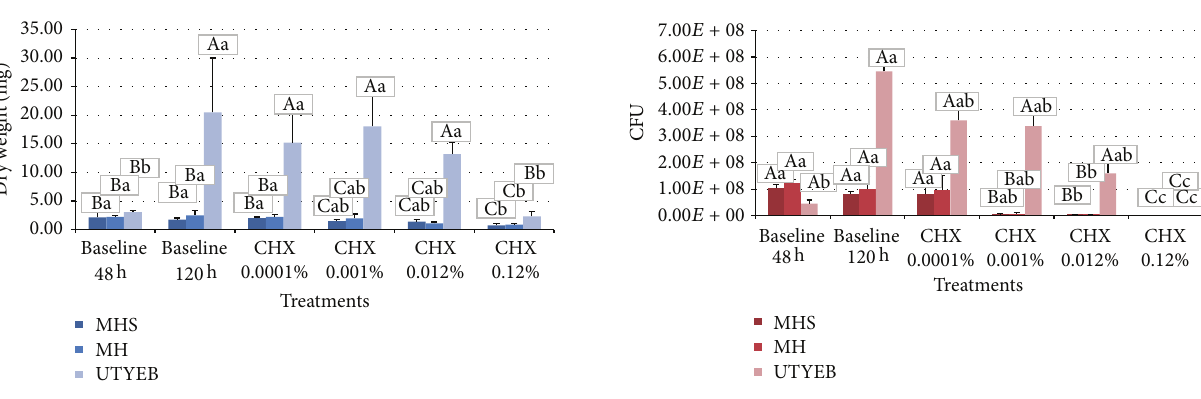
Figure 3: % means and standard deviations of viable bacteria (CFU) in the biofilms growth according to the treatments. Capital letters indicate statistical differences between culture media, and lowercase letters indicate statistical differences according to the treatments using each culture medium, by Tukey test ( 𝑝 < 0.05